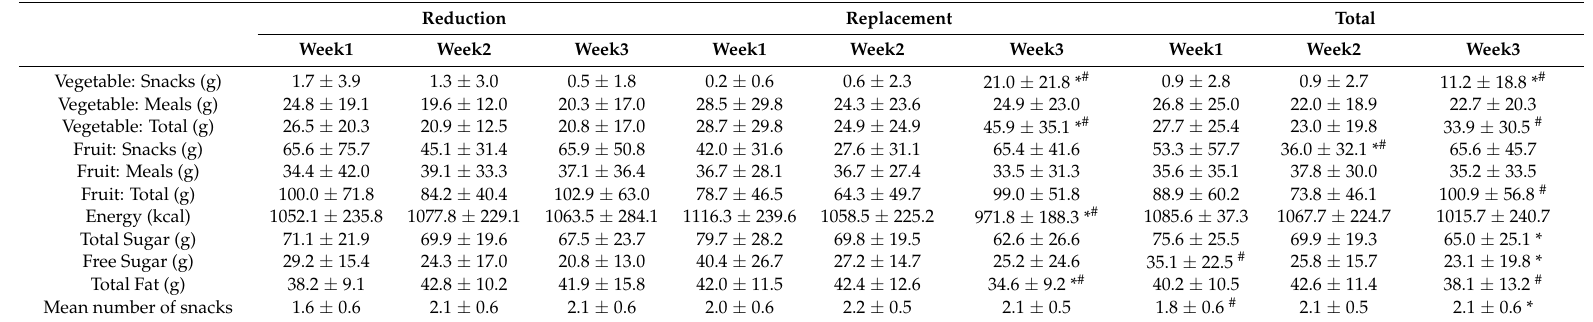
Table 3. Nutritional intake per day in week 1, 2, and 3 (mean ±